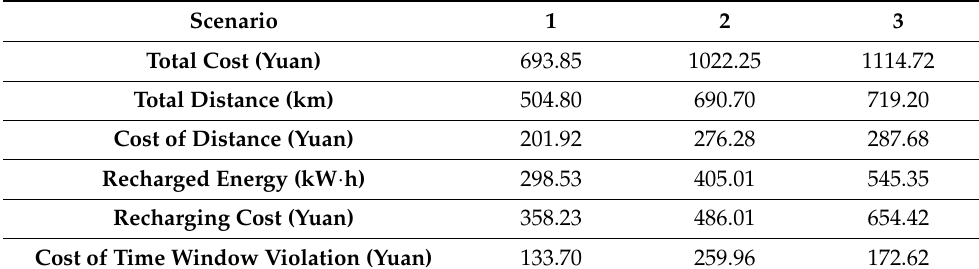
Table 15. Results of